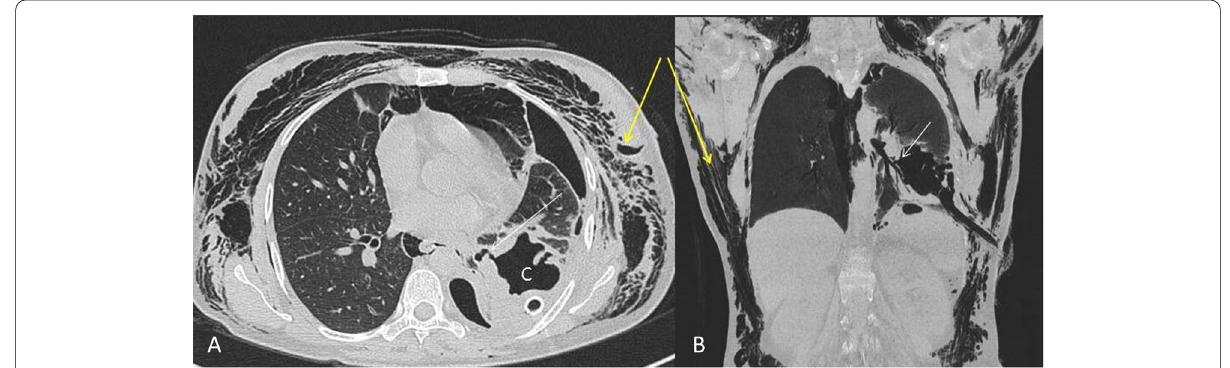
Fig. 3 A Non-contrast axial chest CT and B minimum intensity projection (MinIP) in the coronal plane showing the fistulous communication (white arrows) between the post-operative cavity ( C ) and the segmental bronchus for the lower lobe. Also, a note is made of the extensive subcutaneous emphysema (yellow arrows) and ICD tube in